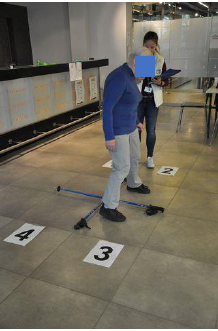
Figure 2. FSST performance with time measurement.